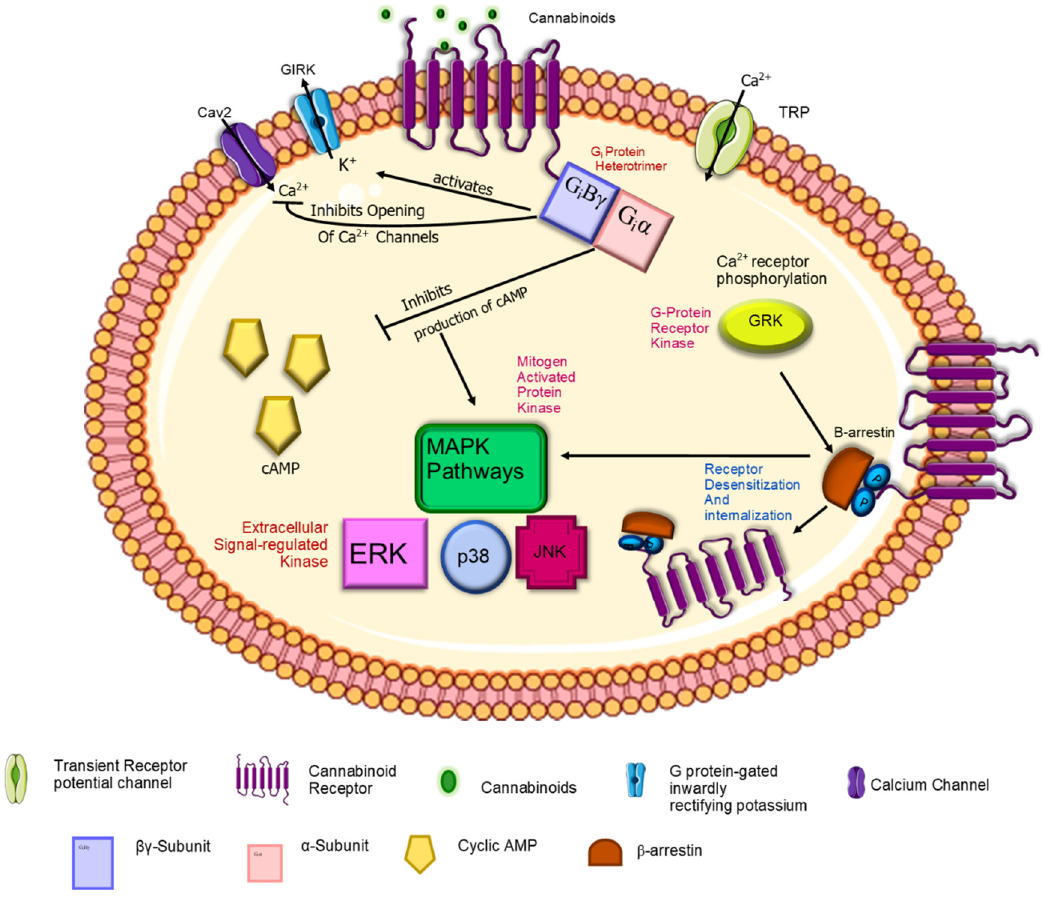
Figure 5. The signal transduction pathways associated with the G (i) signaling complex. The G (i) protein comprises three components, namely alpha, beta and gamma subunits. Therefore, they are called the G i protein heterotrimer. G i α inhibits the production of Camp G i βγ activates K+ channels and inhibits the opening of Ca2+ channels. The downstream effects involve the Mitogen-activated protein kinases pathways; ERK, p38 and JNK. β -arrestin attachment to the G (i) complex initiates receptor desensitization and internalization. Adapted with text and annotation from reference [134]